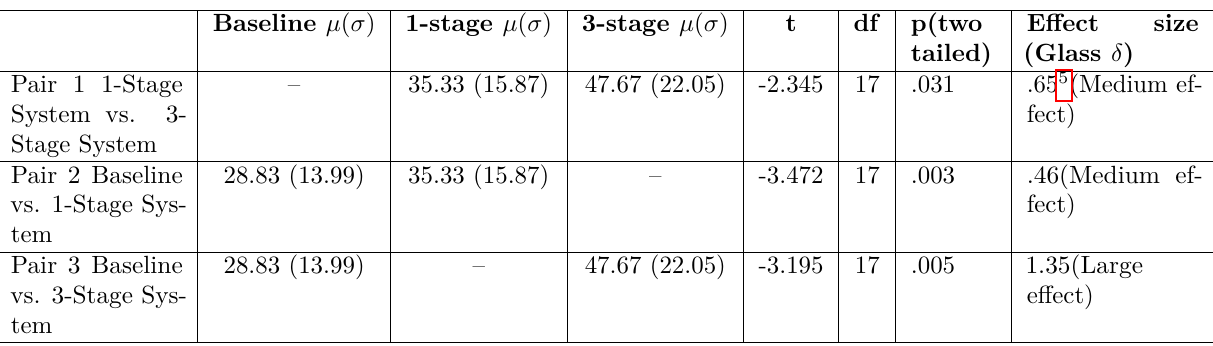
Table 4. Paired-Samples t-test – RSME.